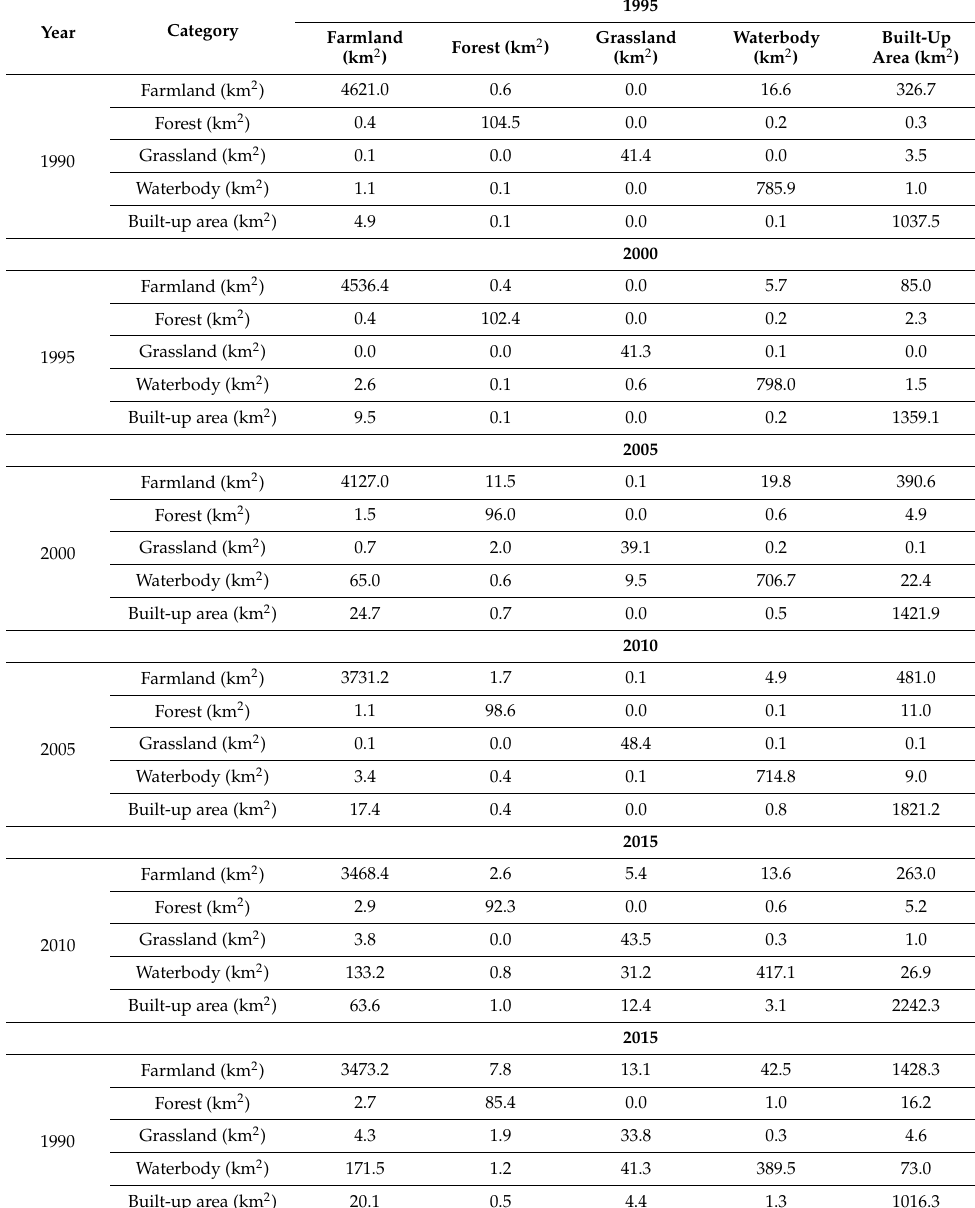
Table 4. The land-use transition matrixes between 1990 and